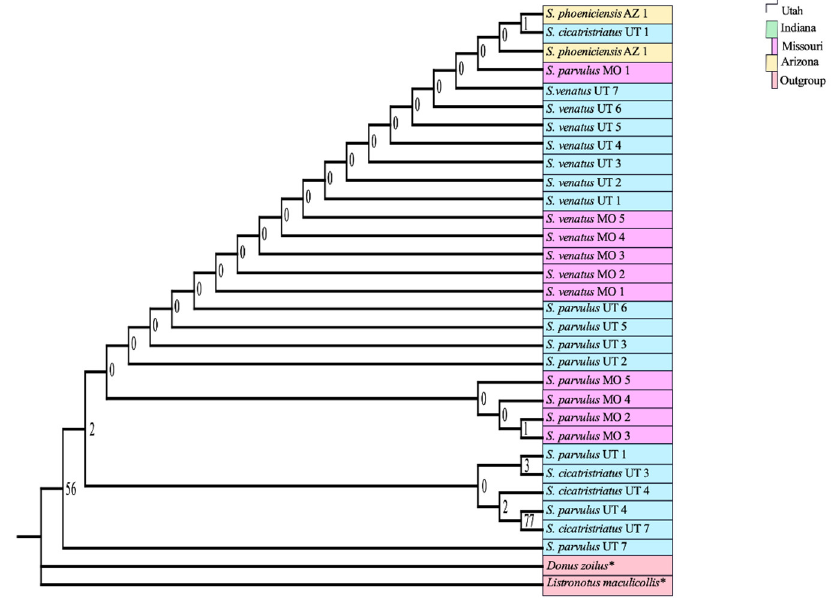
Figure 3. Maximum likelihood tree of 18S sequences from Sphenophorus parvulus , S. venatus , S. inaequalis , and S. cicatristriatus . Collection location is represented by color blocks; Utah (blue), Indi- ana (green), Missouri (purple), Arizona (yellow), outgroups (red). Replicate numbers are indicated to the right of the scientific name and collection state (Utah = UT, Indiana = IN, Missouri = MO, Arizona-AZ). Numbers at nodes are bootstraps values (1000 bootstrap replicates as percentages). * indicates sequences obtained from [17].